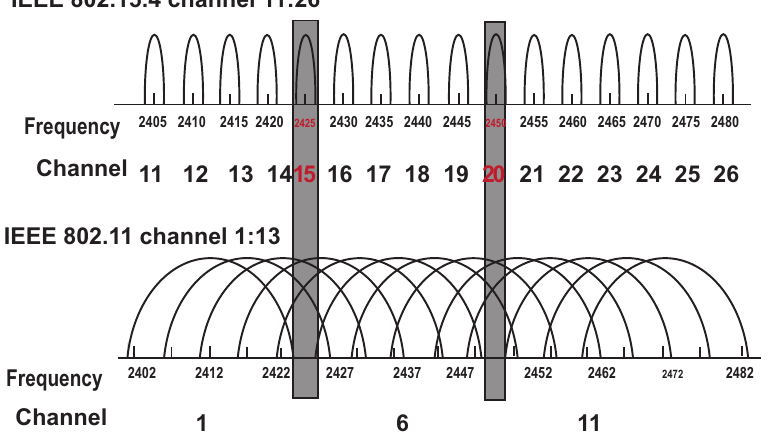
Figure 2. Frequency channels of Wi-Fi IEEE802.11 and ZigBee IEEE802.15.4